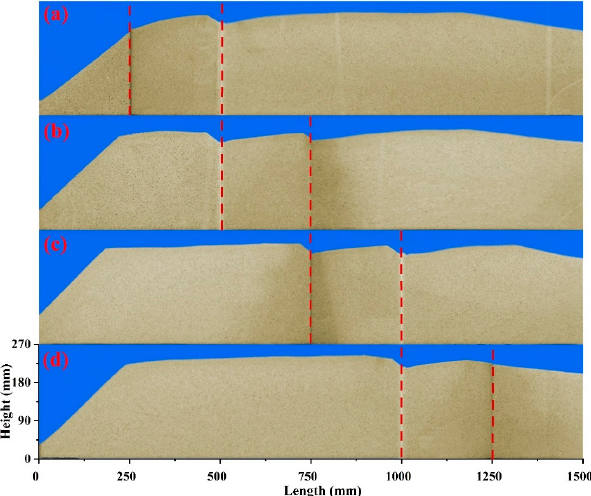
Figure 13. Snapshots of 40/70 mesh sand dunes in four channels at the stable status at Re = 946, S = 0.05 and θ = 90°, front view: ( a ) L 1 /L = 0.16; ( b ) L 1 /L = 0.33; ( c ) L 1 /L = 0.5; ( d ) L 1 /L = 0.66.